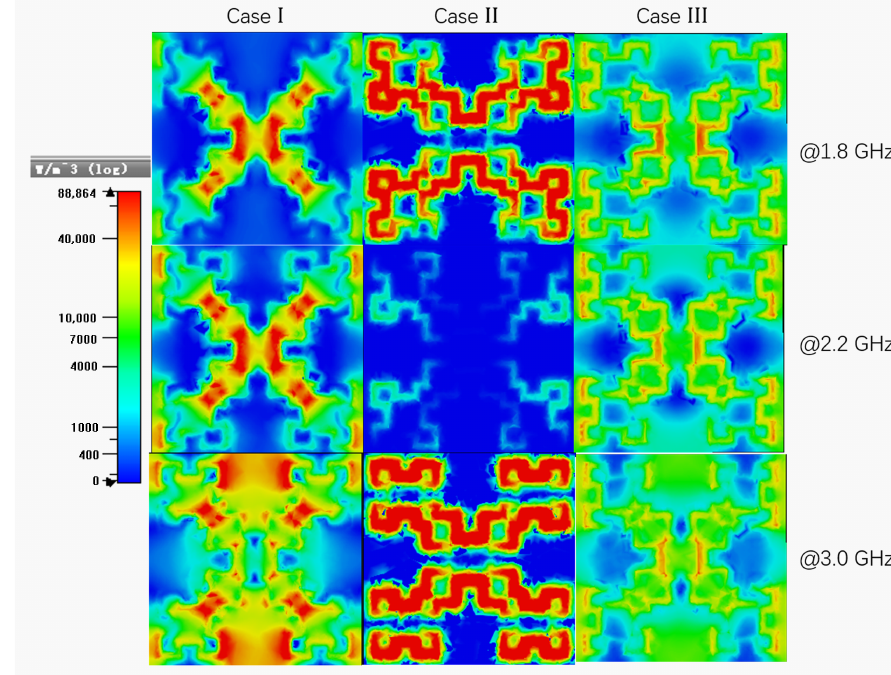
Figure 8. The power loss density distribution of three cases in FR-4 at xoy plane.